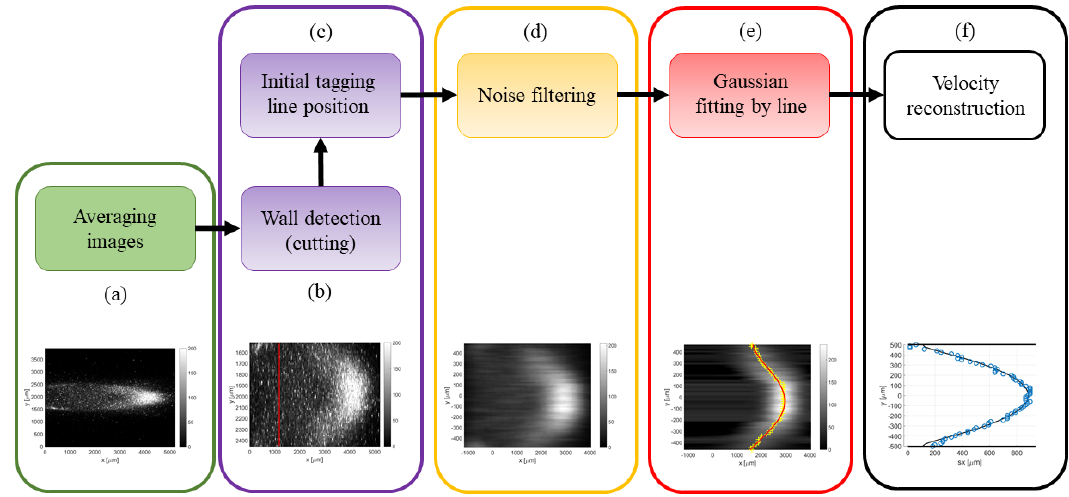
Figure 9. Flow chart of the image post-processing: ( a ) image averaging; ( b ) detecting wall position and image cutting; ( c ) detecting tagged line position; ( d ) filtering background noise; ( e ) Gaussian fitting per each horizontal line of pixels; and ( f ) velocity reconstruction from the displacement data s xj 𝑠 𝑥𝑗 .